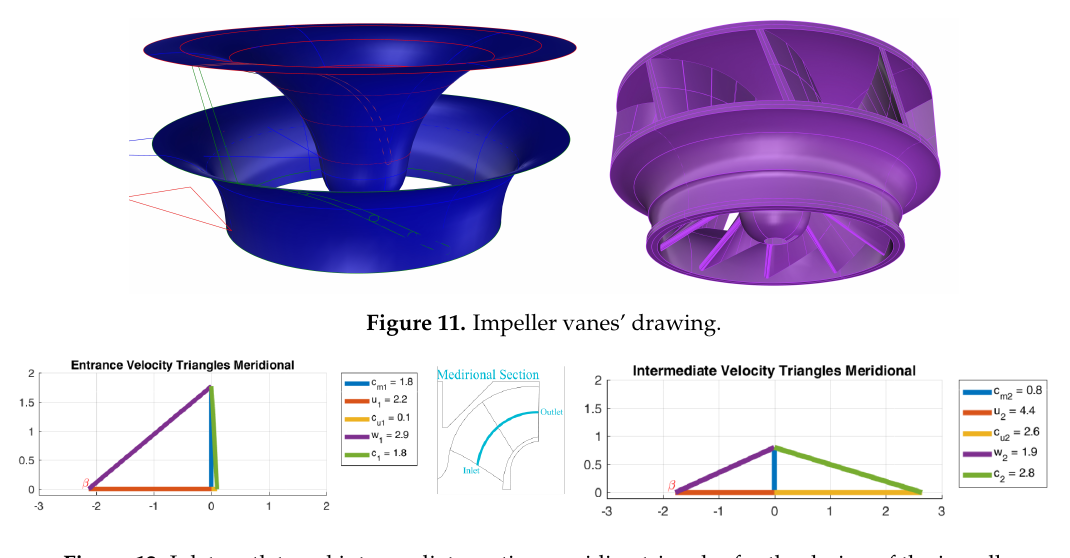
Figure 12. Inlet, outlet, and intermediate section meridian triangles for the design of the